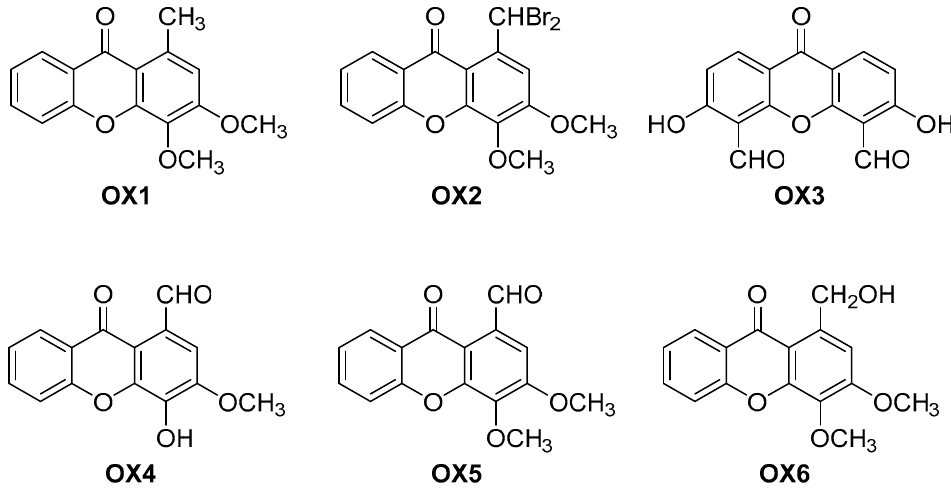
Figure 1. Chemical structures of the oxygenated xanthones OX 1–6 investigated in this study.